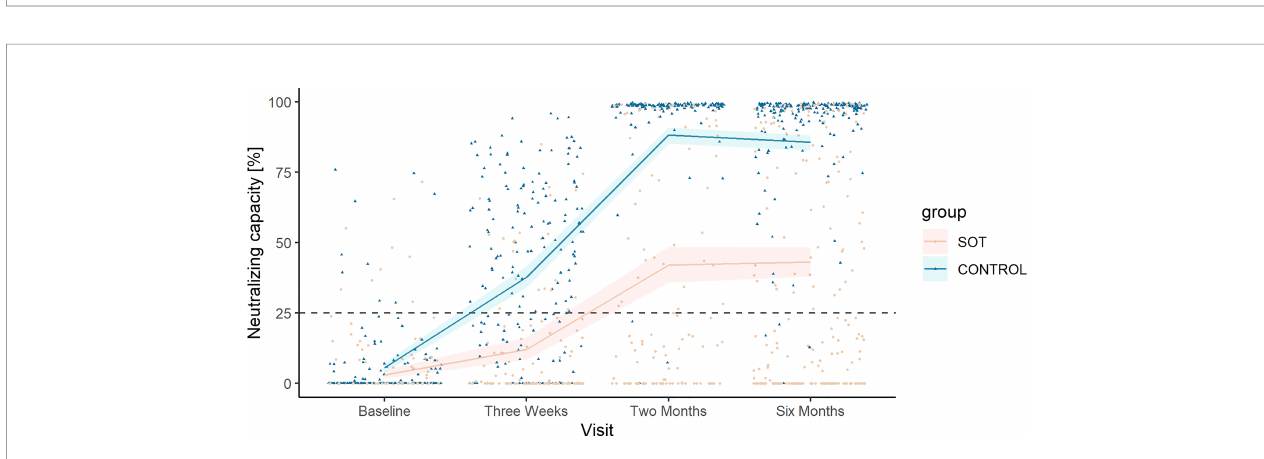
FIGURE 3 | Observed neutralizing capacity and predicted mean neutralizing capacity in solid organ transplant (SOT) recipients and controls. Development in predicted mean neutralizing capacity represented in percent plotted on top of the observed individual neutralizing capacity at each sample time from SOT recipients (yellow) and controls (blue). The dashed horizontal line indicates the minimum threshold for positive humoral